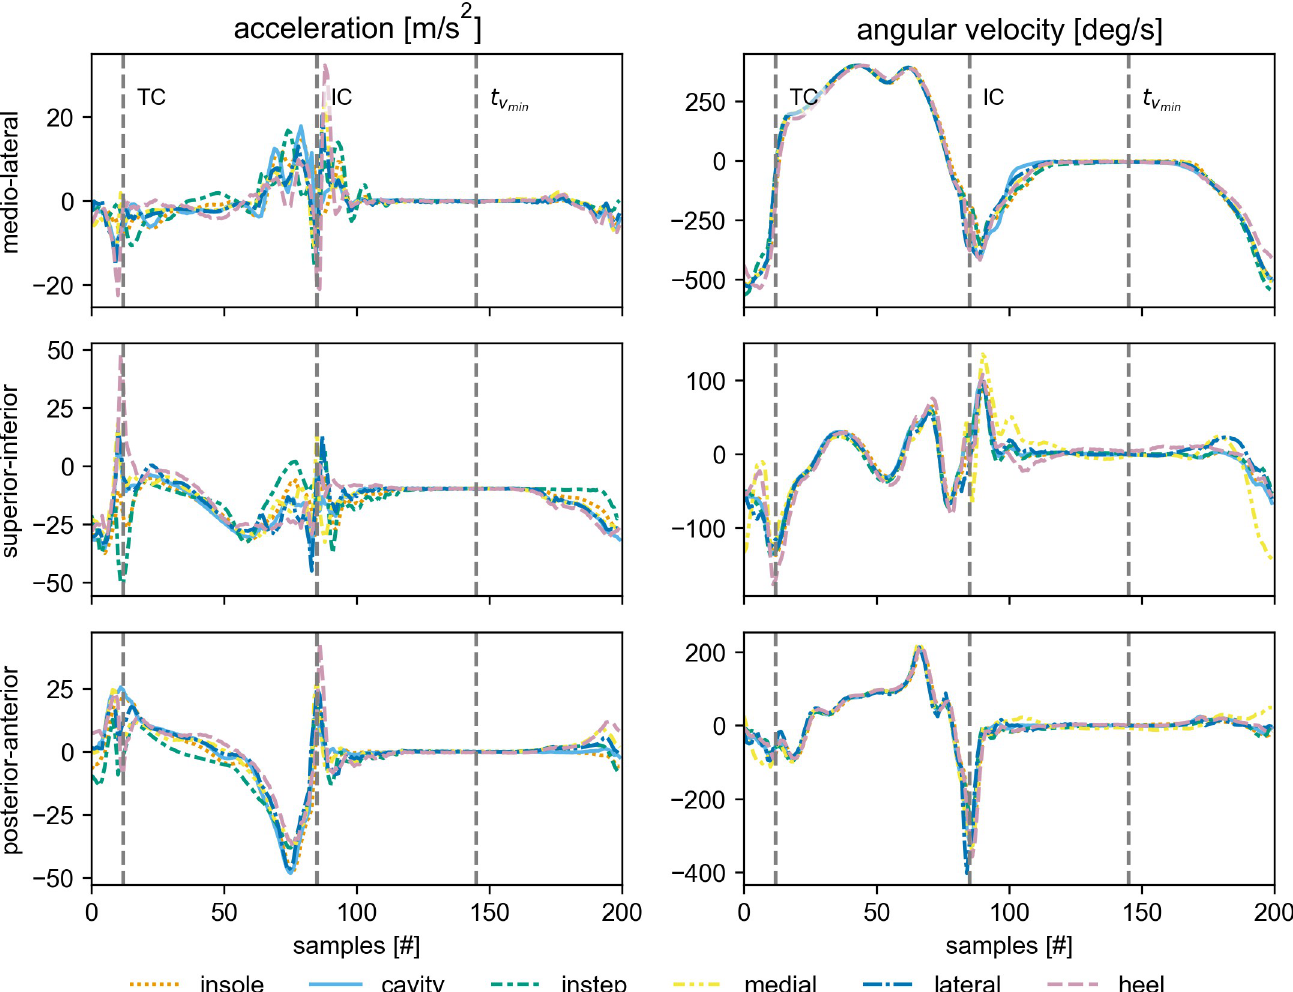
Fig 4. Example stride. The average signal over all strides of the left foot from the 2 × 20m walk test at normal speed of the participant 4d91. All strides were interpolated to 200 samples before averaging. The individual signals are rotated to match the primary anatomical axis during mid-stance. The start and the end of the stride conform with the labeled -stride definition. The vertical lines indicate the approximate position of the detected gait